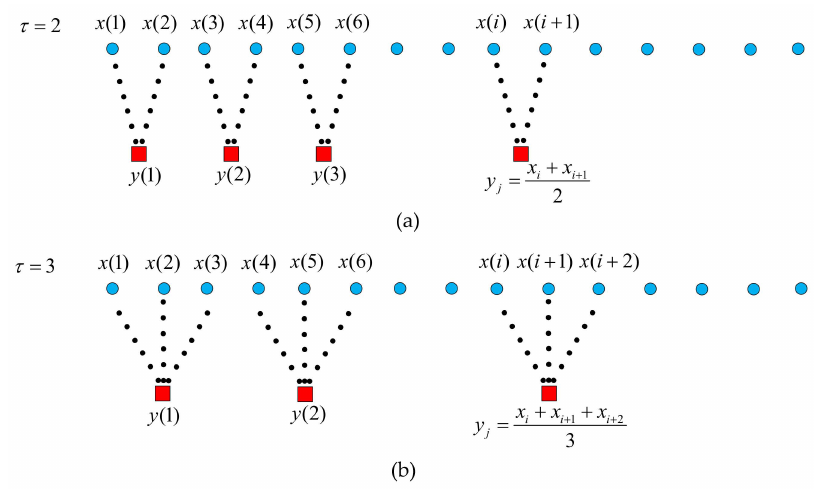
Figure 1. Coarse-graining procedure diagram of multiscale entropy (MSE). ( a ) Scale factor τ = 2; ( b ) Scale factor τ =